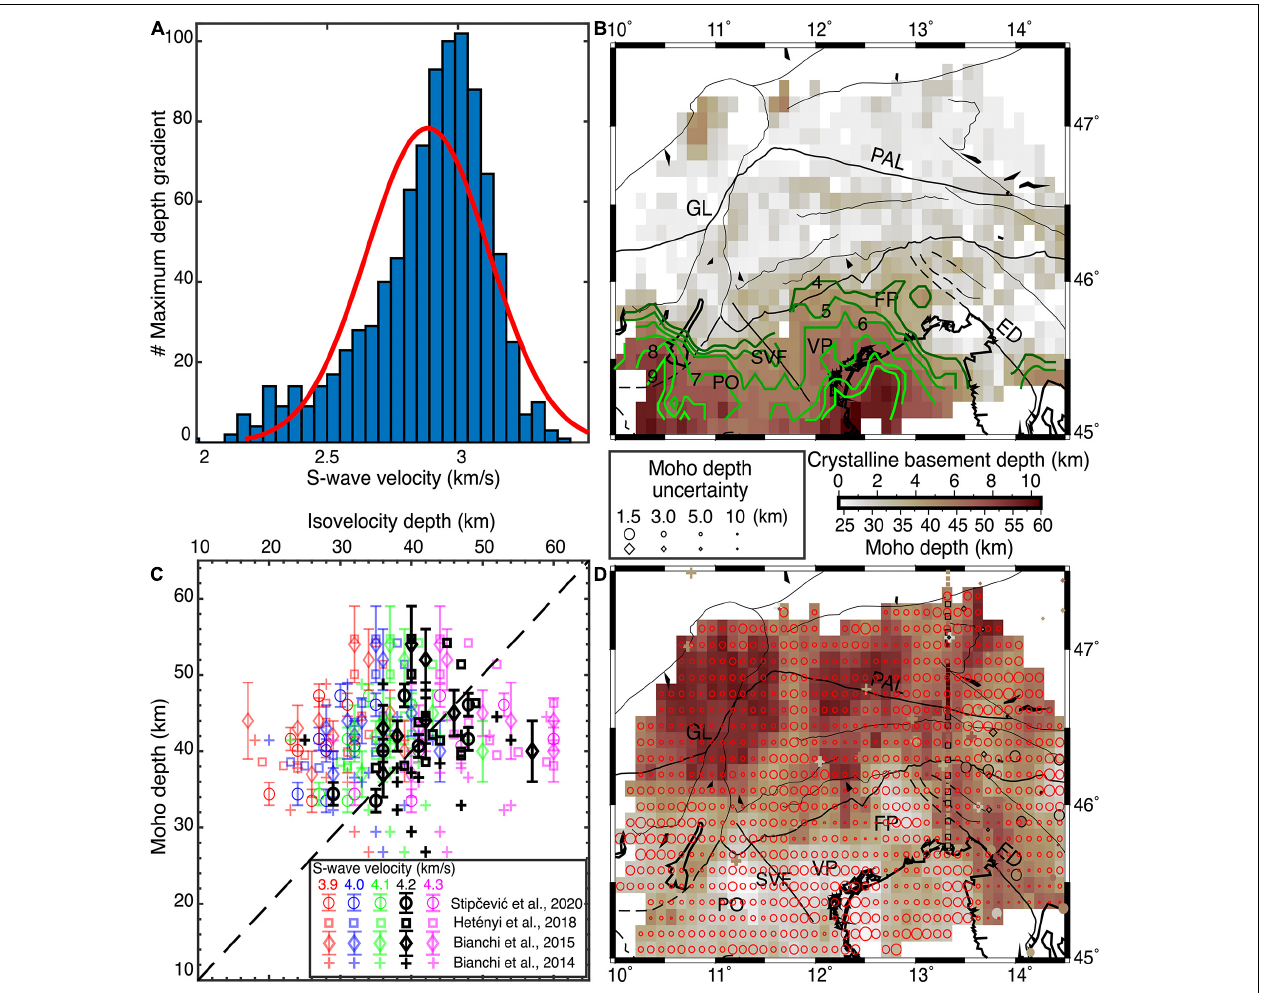
FIGURE 9 | (A) A histogram showing the variation in the number of maximum depth gradients of the 1D S-wave velocity profiles with S-wave velocity. The best fitting normal distribution is shown by red. (B) The crystalline basement depth estimated by the average of iso-velocity depths between 2.8 and 3.0 km/s. Green lines portray the basement depth contours from 4 km (darkest green) to 9 km (lightest green). (C) Comparison between receiver function Moho depths and the depths obtained from iso-velocities ranging from 3.9 to 4.3 km/s. The horizontal axis label is shown on the top axis. (D) Moho depth estimated by the average of iso-velocity depths between 4.1 and 4.3 km/s. The Moho depths adopted from receiver function studies are shown by the same symbols as in (C) and their sizes are proportional to their uncertainty (if it was available). The receiver function depths used for the comparison in (C) are marked by black outline. The size of the red circles represents the uncertainty of the Moho at each node. PAL, Periadriatic Line; SVF, Schio-Vicenza fault; GL, Giudicarie Line; FP, Friuli Plain; VP, Venetian Plain; PO, Po Plain; ED, External